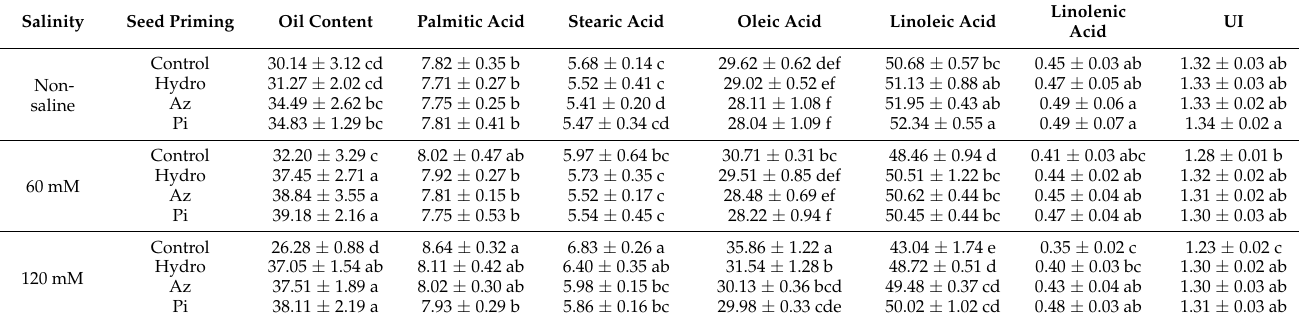
Table 2. Effect of seed priming and salinity on oil content and fatty acids composition of milk thistle seed (%). Salinity Seed Priming Oil Content Palmitic